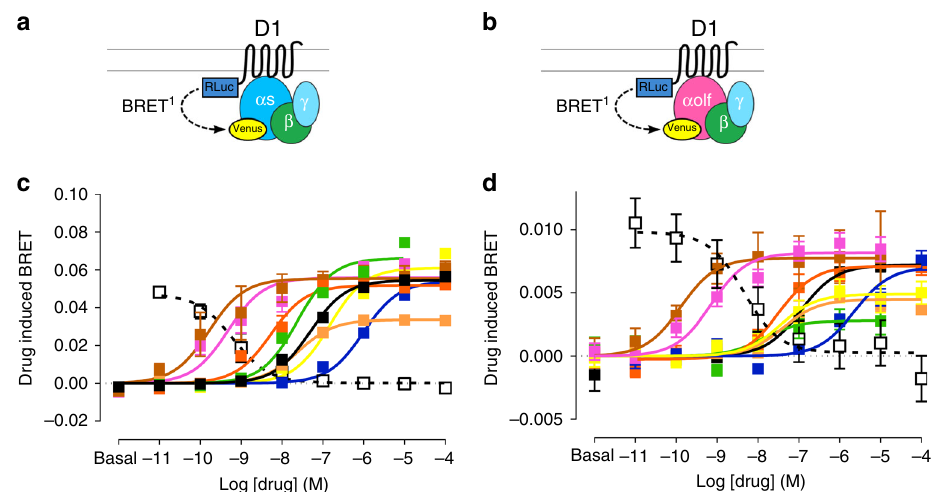
Fig. 1 a Scheme for the engagement BRET between D1R-Rluc and Gs-Venus. b Scheme for the engagement BRET between D1R-Rluc and Golf-Venus. c Dose-response curves of drug-induced BRET between D1R-Rluc and Gs-Venus (black dopamine, blue norepinephrine, light orange SKF38393, dark orange SKF81297, brown SKF82958, yellow NPA, green DHX, magenta A77636, black open SCH23390+ 10 − 6 SKF81297). d Dose-response curves of BRET between D1R-Rluc and Golf-Venus (same color scheme). The error bars represent